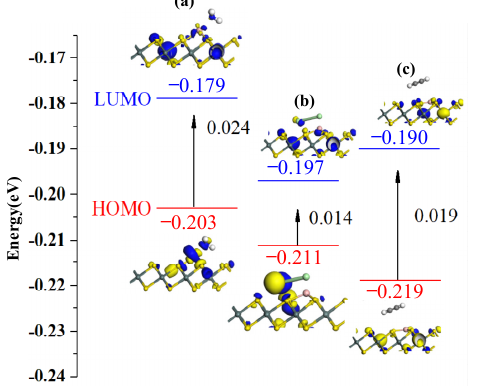
Figure 8. HOMO and LUMO of gas-adsorbed B-SnS 2 systems: ( a ) B-SnS 2 /NH 3 , ( b ) B-SnS 2 /Cl 2 , ( c ) B-SnS 2 /C 2 H 2 .